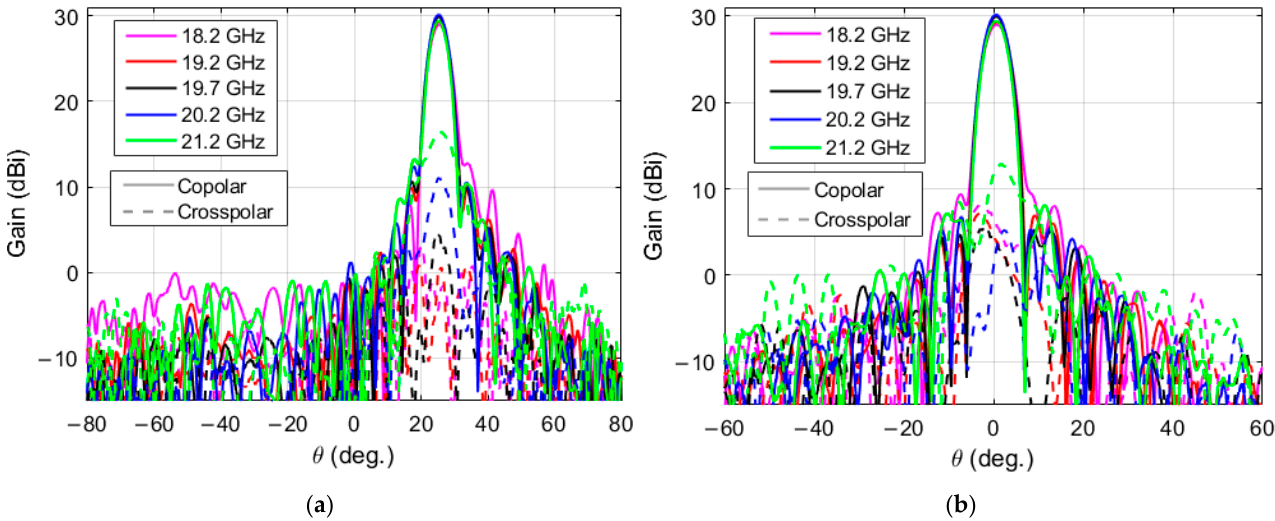
Figure 9. Measured radiation patterns at several frequencies (from 18.2 to 21.2 GHz) for the beam produced in LHCP: ( a ) in the xz -plane and ( b ) in the azimuth plane.